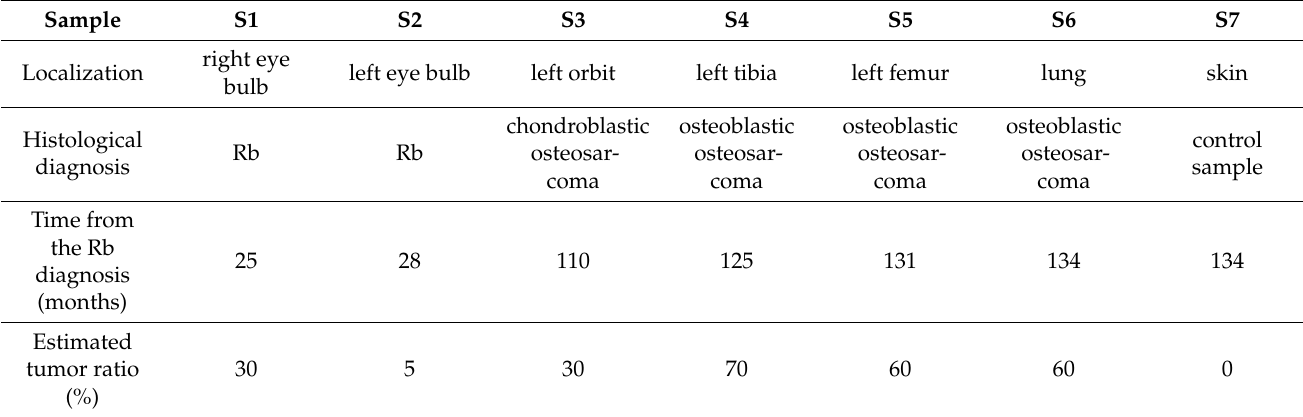
Table 1. Sample types and related histological diagnoses of the seven tissue samples used for DNA sequencing. S1–S7: sample 1–7, Rb: